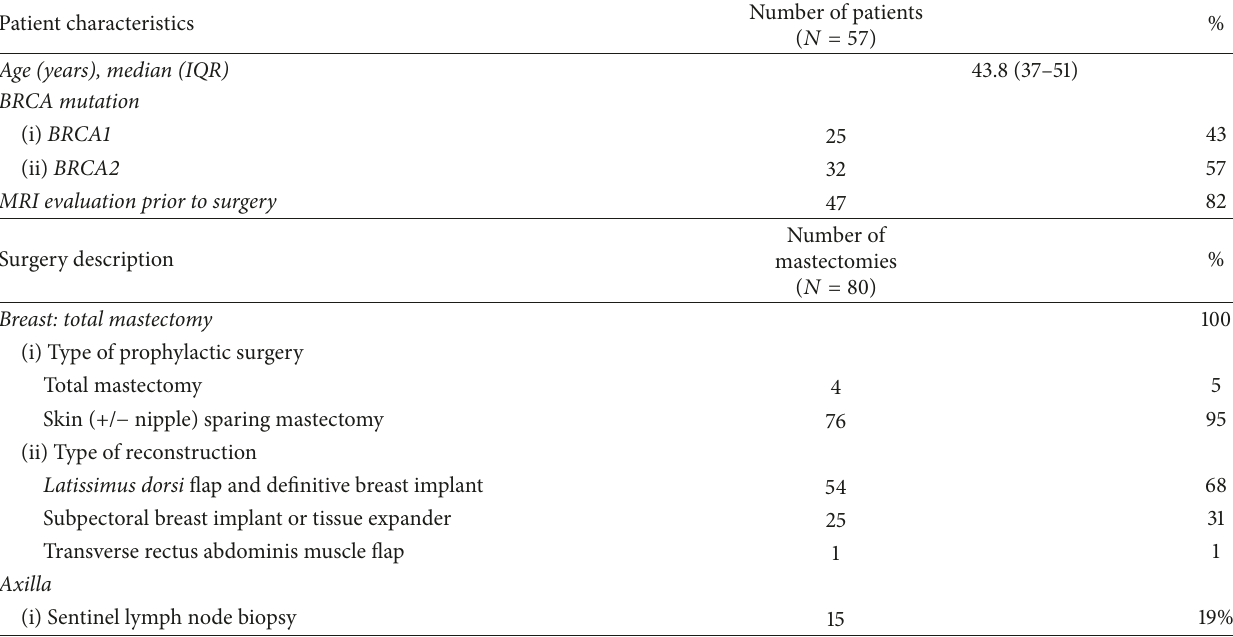
Table 1: Descriptive analysis of the prophylactic mastectomy